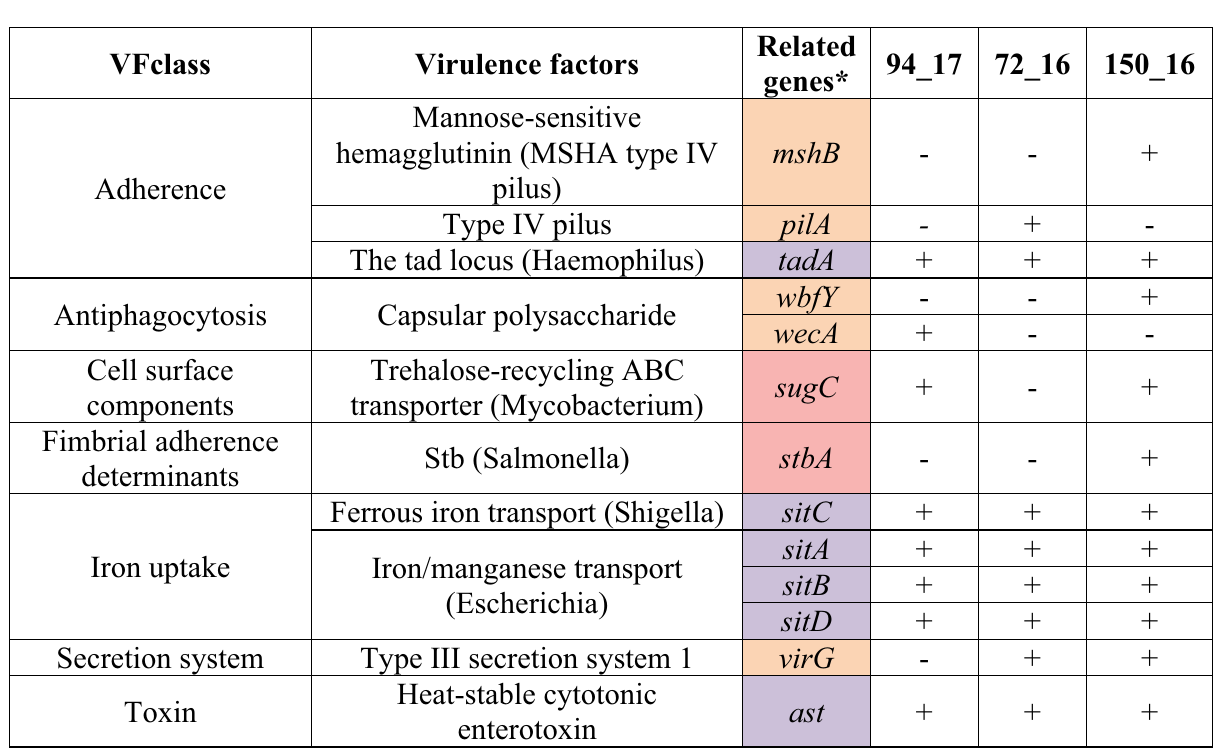
Table 5. Virulence genes detected by VFanalyzer with differences among V . harveyi strains or associated with the genus Vibrio for the first time. *Orange—virulence genes with differences among the studied